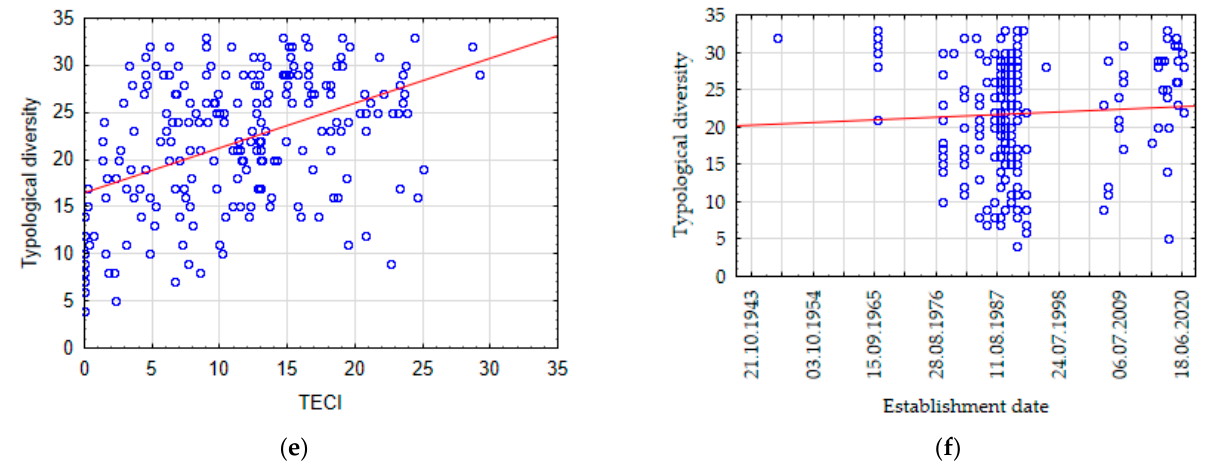
Figure 7. Scatterplots and approximating functions between typological diversity and environ- mental variables: ( a )—PAFRAC, ( b )—area of PAs, ( c )—distance to Moscow, ( d )—LPI, ( e )—TECI, ( f )—establishment date.